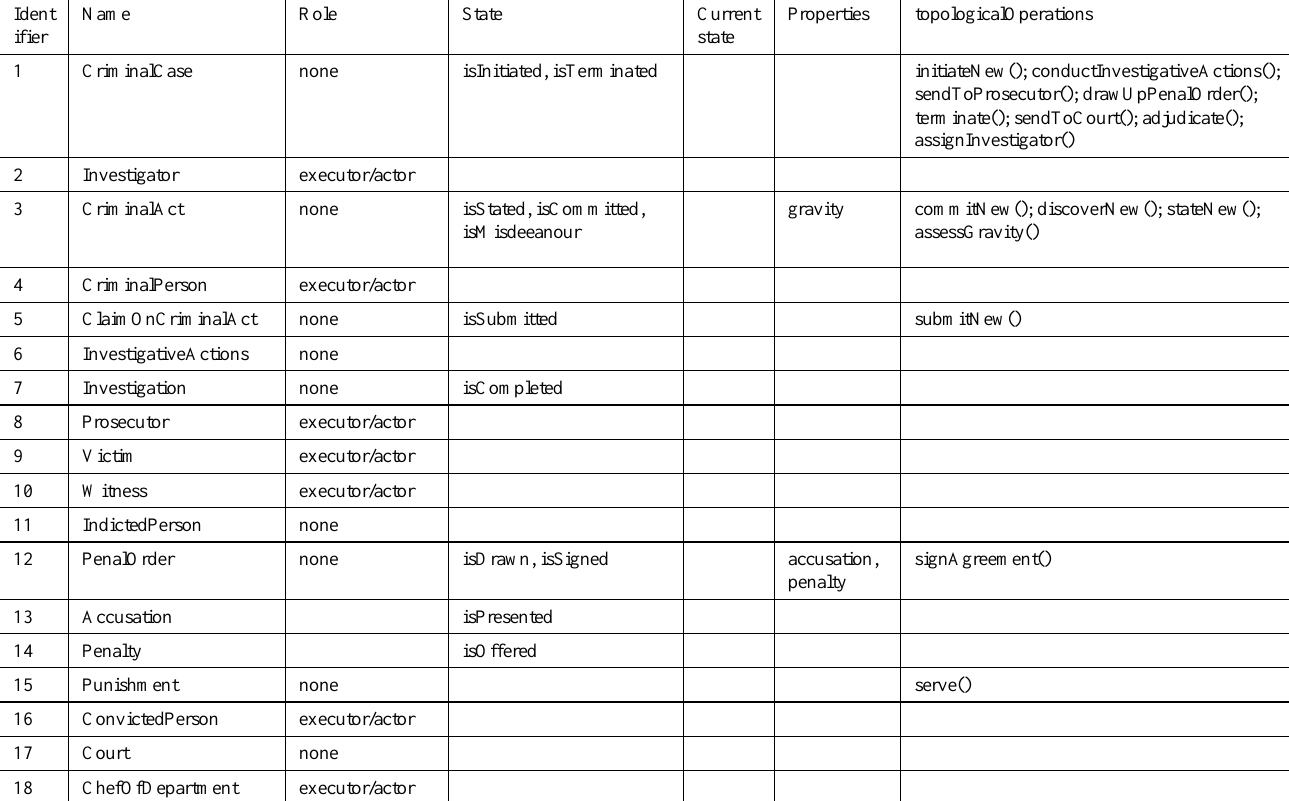
F RAME I NSTANCES FOR O BJECT [7]